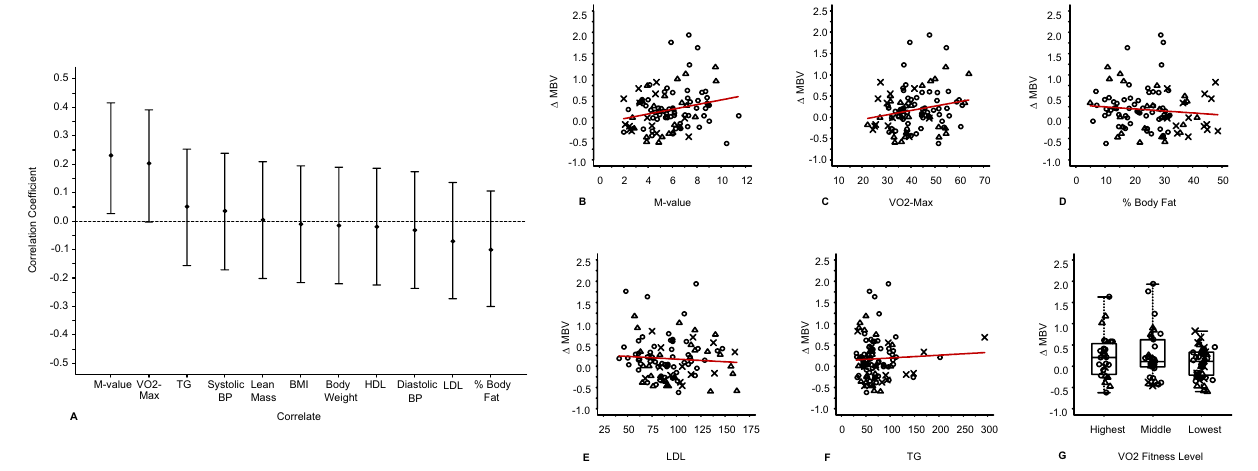
Figure 2. Bivariate relationships between ΔMBV and prediction variables. ( A ) Pearson correlations between ΔMBV and subject characteristics. The vertical lines indicate the 95% confidence interval for the correlation coefficient. ( B – F ) Relationships between ΔMBV and individual predictor variables. The red lines represent the ordinary least squares linear regressions. ( G ) Relationship between ΔMBV and cardiorespiratory fitness. BMI, body mass index; BP, blood pressure; HDL, high-density lipoprotein cholesterol; LDL, low density lipoprotein cholesterol; TRI, triglycerides; VO 2 max, maximum consumption of oxygen (mL/kg/min); VO2 fitness, level of cardiorespiratory fitness by tertile. Plotting symbols: Healthy°, Obese ˟ , Type 1 diabetes Δ